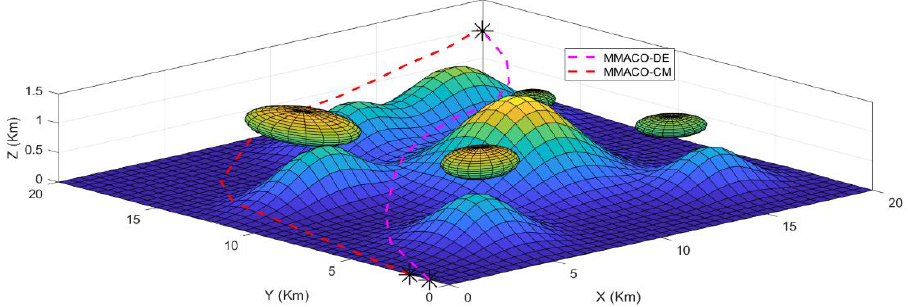
Figure 6. Case 2; 3D view path followed by UAV1 (MMACO-DE) and UAV2 (MMACO-CM) to the the target (*). target (*).